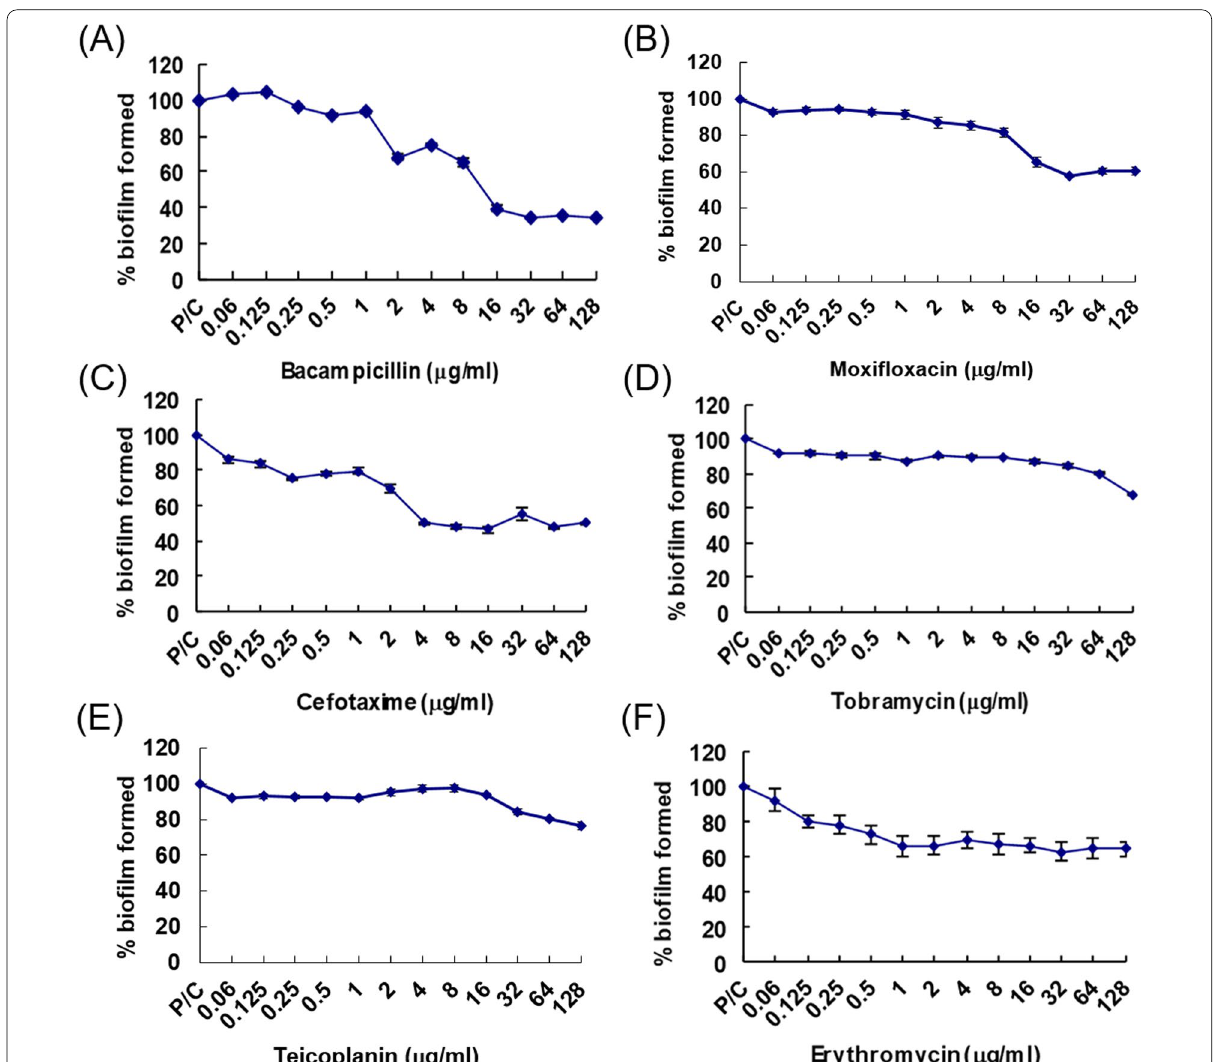
Fig. 3 Biofilm detachment for CYL1106 strains in the presence of the antibiotics. Antibiotic with the lowest difference in MBCs between planktonic and CYL1106 strains was selected: A bacampicillin, B moxifloxacin, C cefotaxime, D tobramycin, E teicoplanin, and F